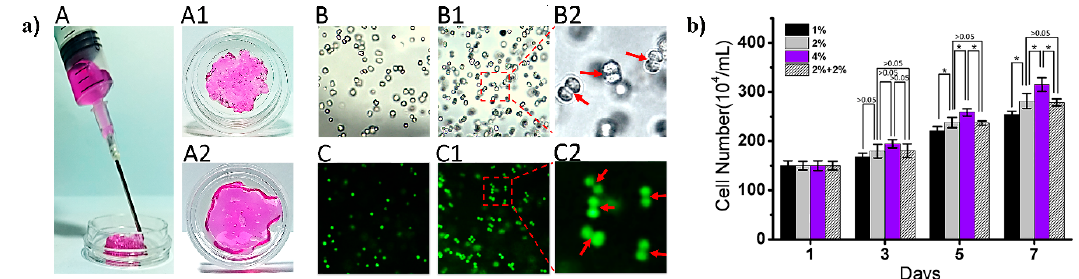
Figure 5. ( a ) Injection and self-healing of the cell-laden GC/DF PEG hydrogel (A, A1 and A2), and the optical microscopy (B and B1) and fluorescent images (C and C1) of the embedded cells on 1st and 7th day culture, respectively. B2 and C2 are the 4 times magnification of the red squares in image B1 and C1, respectively. The red arrows indicate the cell divisions; ( b ) cell numbers in a series of hydrogels with different mass fractions of DF-PEG at denoted time after injection. ‘2% + 2%’ refers to a hydrogel containing 2% DF-PEG and 2% PEG without aldehyde groups, which contained the same mass of PEG as the hard hydrogel (4%), while the modulus was similar to that of the medium hydrogel (2%). Data represent mean ± SD ( n = 3, *: p < 0.05). Reprinted with permission [40]. Copyright 2017, Elsevier